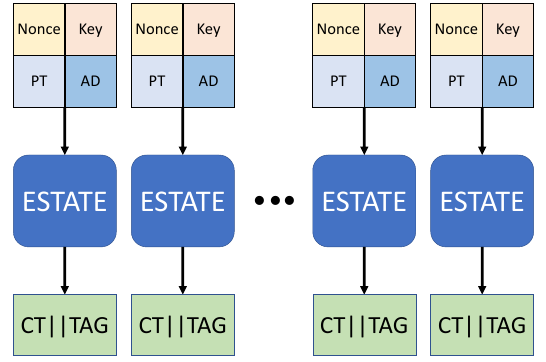
Figure 13. Structure of ESTATE algorithm operation using parallel